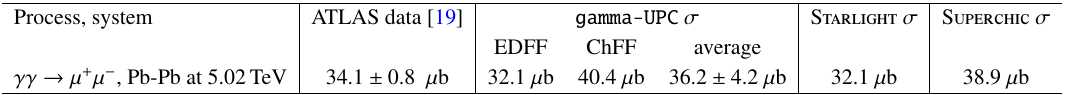
p = 5 : 02 TeV (with s NN